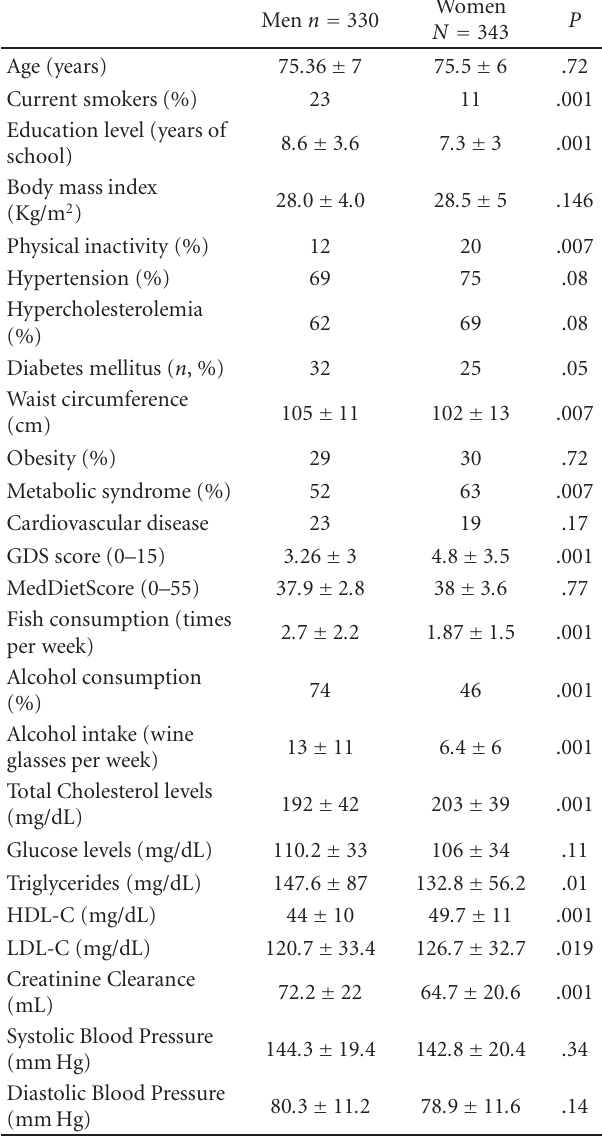
Table 1: Characteristics of the study’s